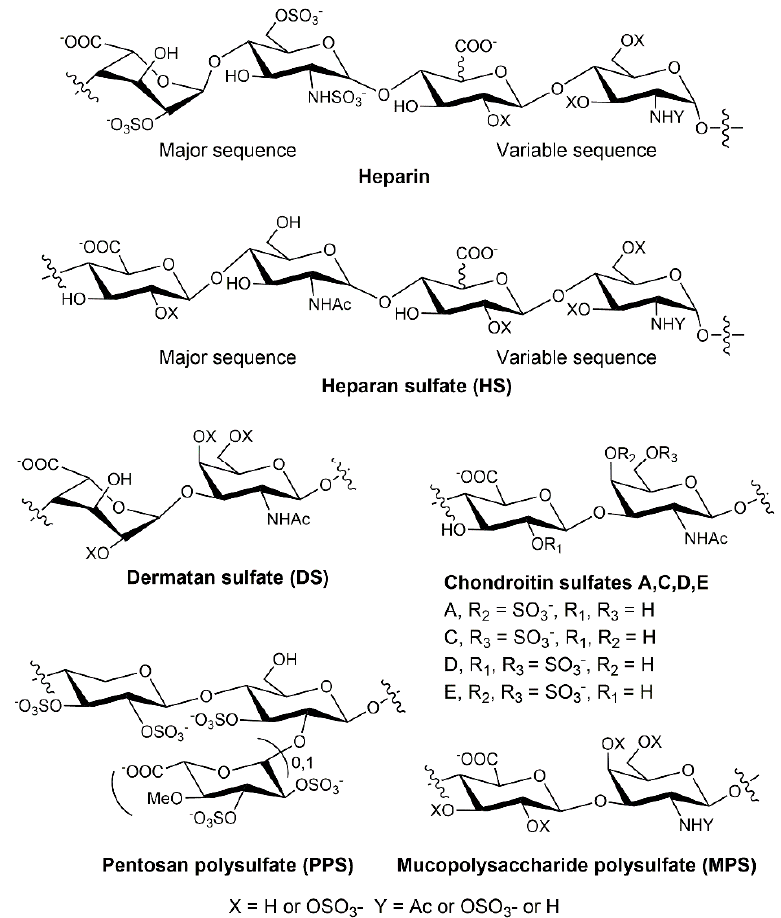
Figure 2. Chemical structures of GAGs (including heparin, HS, CS, and DS) and heparin analogs (PPS and